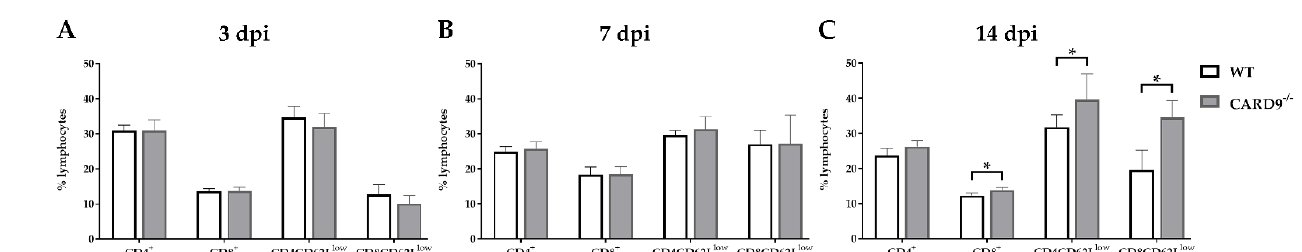
Figure 5. Flow cytometric analysis of CD4 + and CD8 + T cell responses. Quantification of CD4 + , CD8 + , CD4 + CD62L low and CD8 + CD62L low T cells in the spleen of C57BL/6 wild-type (WT) and CARD9 −/− mice following Theiler’s murine encephalomyelitis virus (TMEV) infection at ( A ) 3 days post infection (dpi), ( B ) 7 dpi and ( C ) 14 dpi. * Significant difference between WT and CARD9 −/− mice ( p ≤ 0.05; Mann–Whitney U -test). Three dpi: WT n = 10, CARD9 −/− n = 10; 7 dpi: WT n = 10, CARD9 −/− n = 9; 14 dpi: WT n = 10, CARD9 −/− n = 10. Data are displayed as mean with SD.